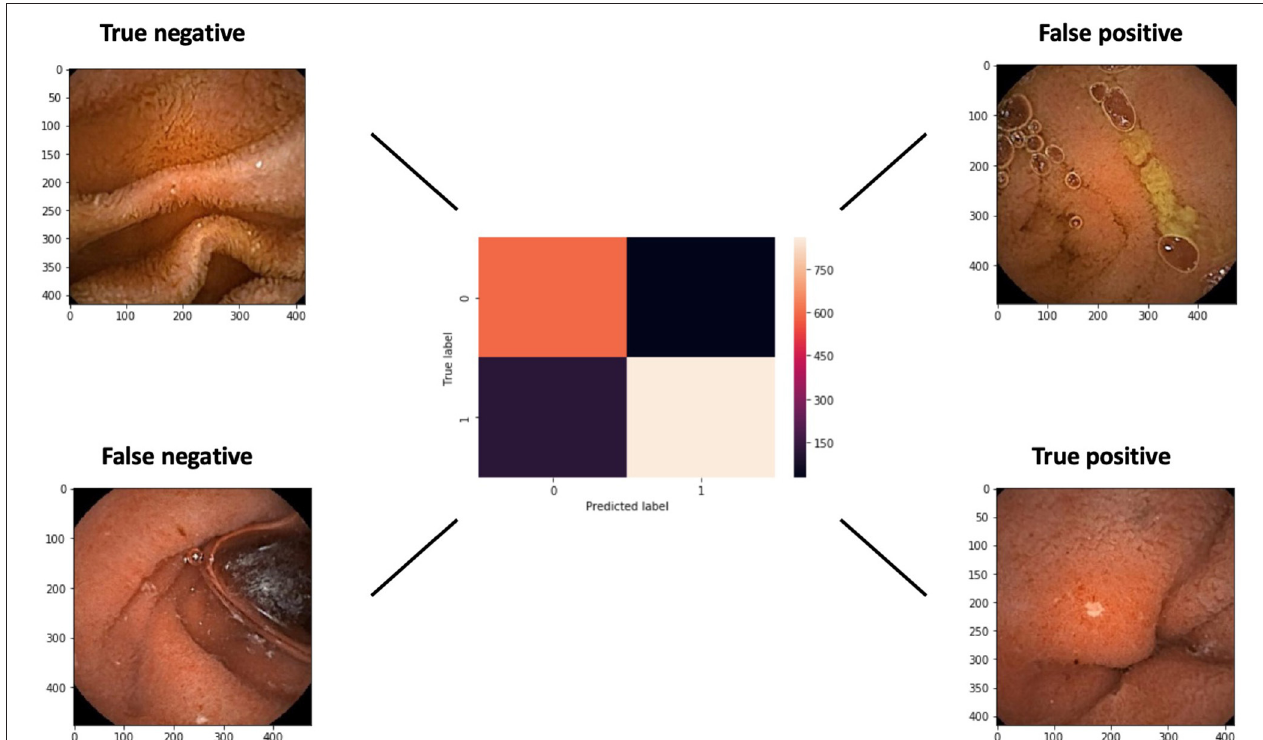
FIGURE 5 | A confusion matrix of the networks results for a cut-off probability of 0.5. Examples of false and true negative and positive images are shown.